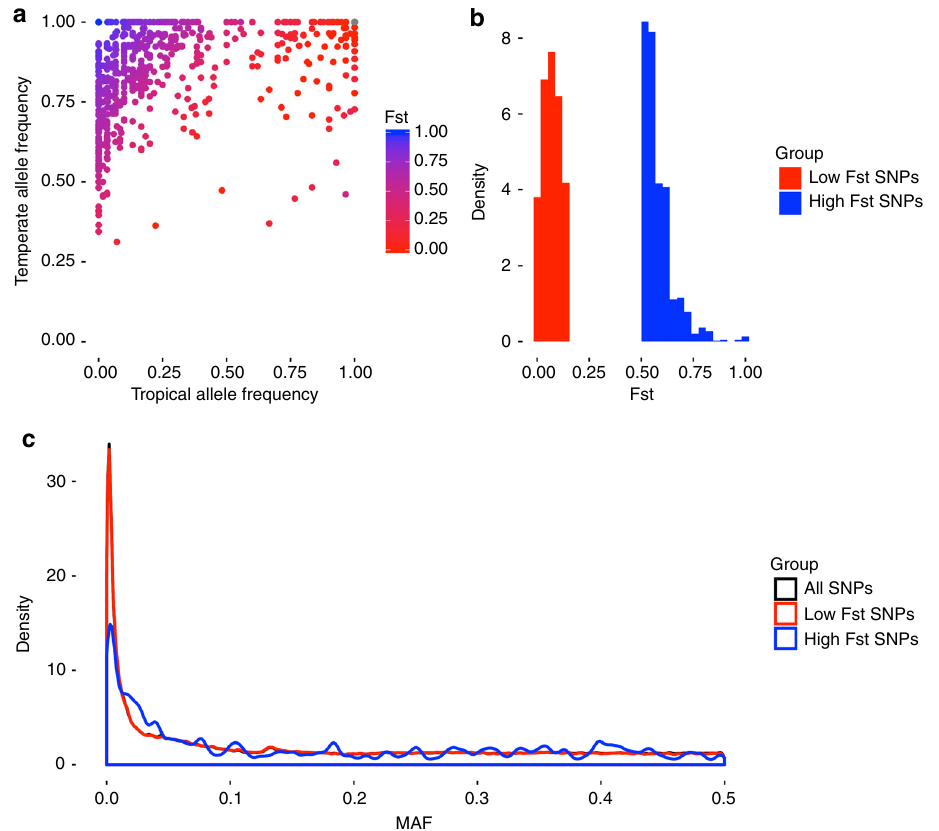
Fig. 3 Comparisons of high and low F ST SNPs. a Allele frequencies within the 30 temperate and 30 tropical inbred lines from Hapmap 3.1 for 736 high F ST SNPs that overlap between Hapmap 3.1 and the G × E hybrid lines. Some SNPs with F ST < 0.5 were designated as high F ST because they lie in a window with mean F ST > 0.5. b Histograms of F ST distributions of 1248 high F ST SNPs and 263,243 low F ST SNPs from the G × E hybrid data set. F ST values represent means of 20-SNP windows. c Distributions of the minor allele frequencies (MAF) in the G × E hybrid data set for 1248 high F ST SNPs, 263,243 low F ST SNPs, and the entire set of 372,273 polymorphic